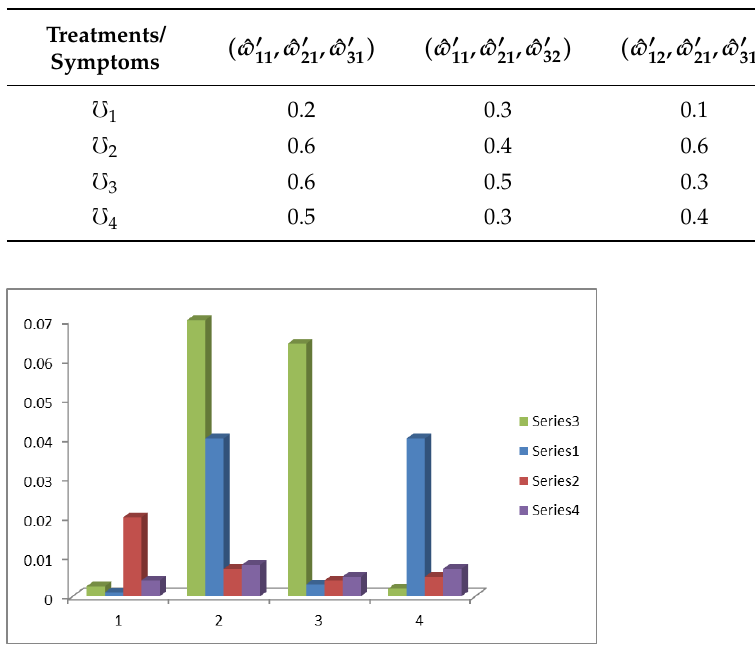
Table 12. χ F (cid:48) is represented in a tabular format: Doctor’s advice for COVID symptoms and the appropriate treatment.